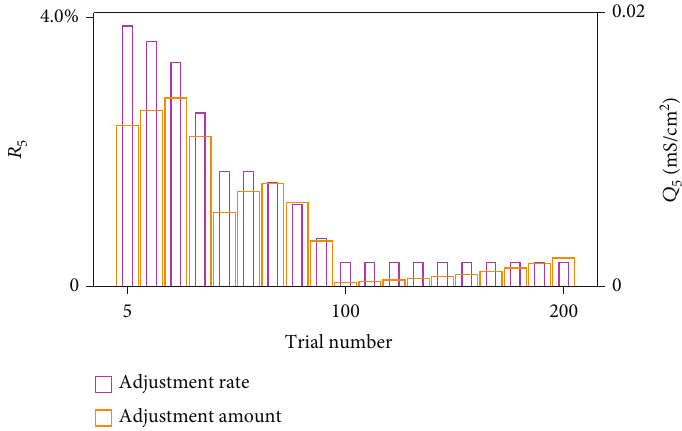
Figure 14: The mean adjustment of AFP every 5 trials during DAF. The highest adjustment rate is 4% for fi ve trials, and the highest adjustment amount is 0.02mS/cm 2 . With an increasing number of trials, Q during some